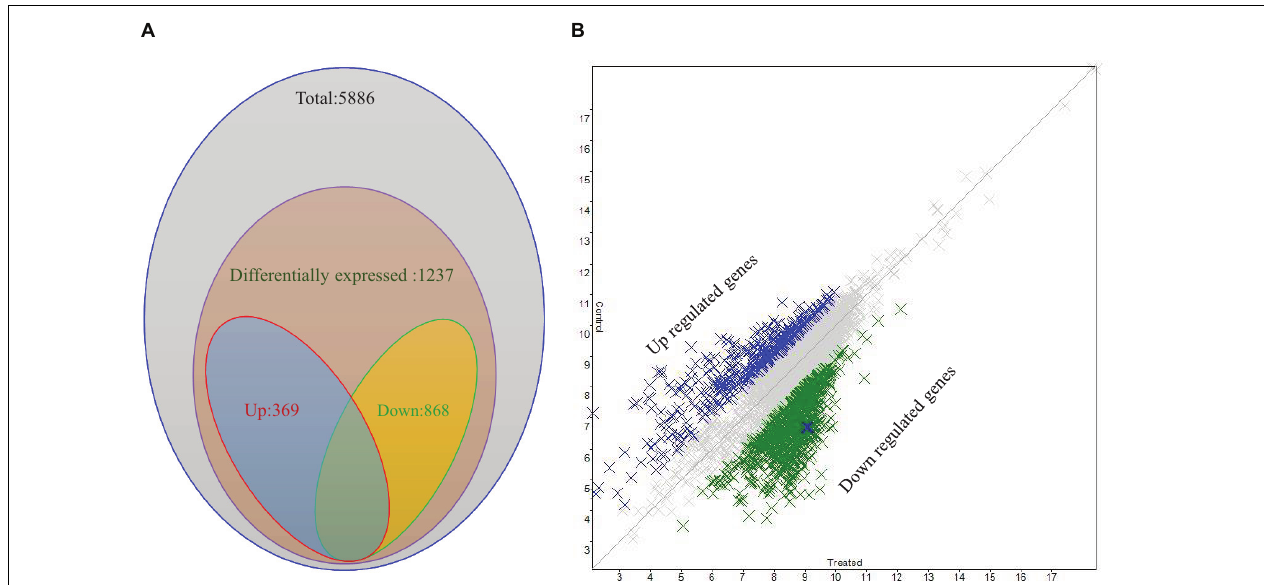
FIGURE 6 | Differential expression analysis of P. aeruginosa PAO1 treated with SJ16 extract. (A) Venn diagram and (B) Scattered plot showing genes differentially expressed in P. aeruginosa PAO1 as determined by